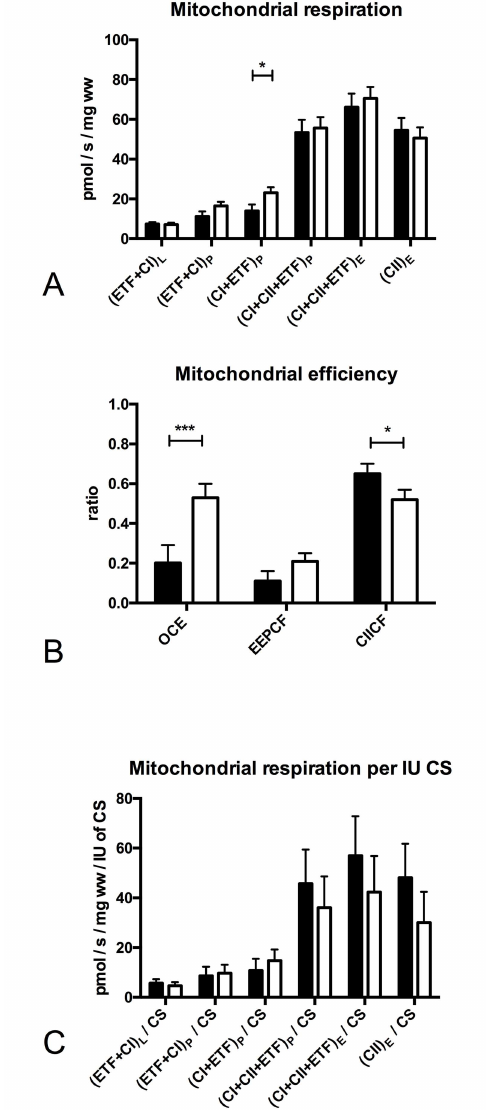
Fig 2. Mitochondrial respiration, efficiency and mitochondrial respiration per international unit of citrate synthase activity at baseline. Mitochondrial respiration(pmol O 2 /s/ mg wet weight of muscle fibers). (A) (ETF+CI)L is the LEAK state electron transfer through electron transferring flavoprotein (ETF) and complex I after addition of the substrates octanoylcarnitin (0.2mM) + malate (2mM), in the absence of ADP; (ETF+CI)P is fatty acid oxphos capacity after addition of ADP (2.5mM); (CI+ETF) P is electron transfer through complex I and ETF reaching complex I oxphos capacity after addition of glutamate(10mM); (CI+II +ETF)P is electron transfer through complex I, II and ETF reaching complex I and II oxphos capacity after additionof succinate (10mM) and ADP (5mM); (CI+II+ETF)E is electron transfer through complex I, II and ETF reaching ETS capacity after FCCP titrations (0.5M max. 3M) to uncoupleoxidationfrom phosphorylation; (CII) E is ETS capacity supported by complex II after addition of rotenone(0.5M), which inhibits complex I. The subscripts L,P,E indicate the LEAK state, OXPHOS and ETS capacity (B) Mitochondrial efficiency at baseline:OCE: oxphos coupling efficiency (1 - (ETF+CI) L / (ETF+CI) P ); EEPCF: Excess ETS-phophorylationcapacity factor (1 - (CI+CII+ETF) P / (CI+CII+ETF) E ), CII CF: complex II control factor (1 - (CI+ETF) P / (CI+CII+ETF) P ) (C) Mitochondrial respirationper international unit of citrate synthase (CS). Black (patients with PVD n = 11), White (healthy older adults n = 11). Values are mean and standard error of the mean, comparison between groups, Significantdifferences between groups * Significantly different between groups (P < 0.05), ** Significantly different between groups (P < 0.01), *** Significantly different between groups (P <